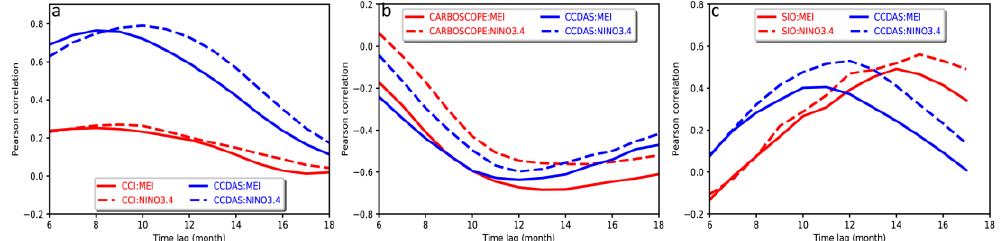
Figure A4. Relations between Pearson r and time lag. ( a ), changes in Pearson r for CCI soil moisture and CCDAS-optimized soil moisture with time lag response of soil moisture to two ENSO indices, MEI and Niño 3.4. ( b ), same as ( a ), but for atmospheric inversion from Jena CarboScope and CCDAS-optimized NEP. ( c ), same as ( a ), but for global CO 2 growth rate (CGR) from SIO and CCDAS optimization.